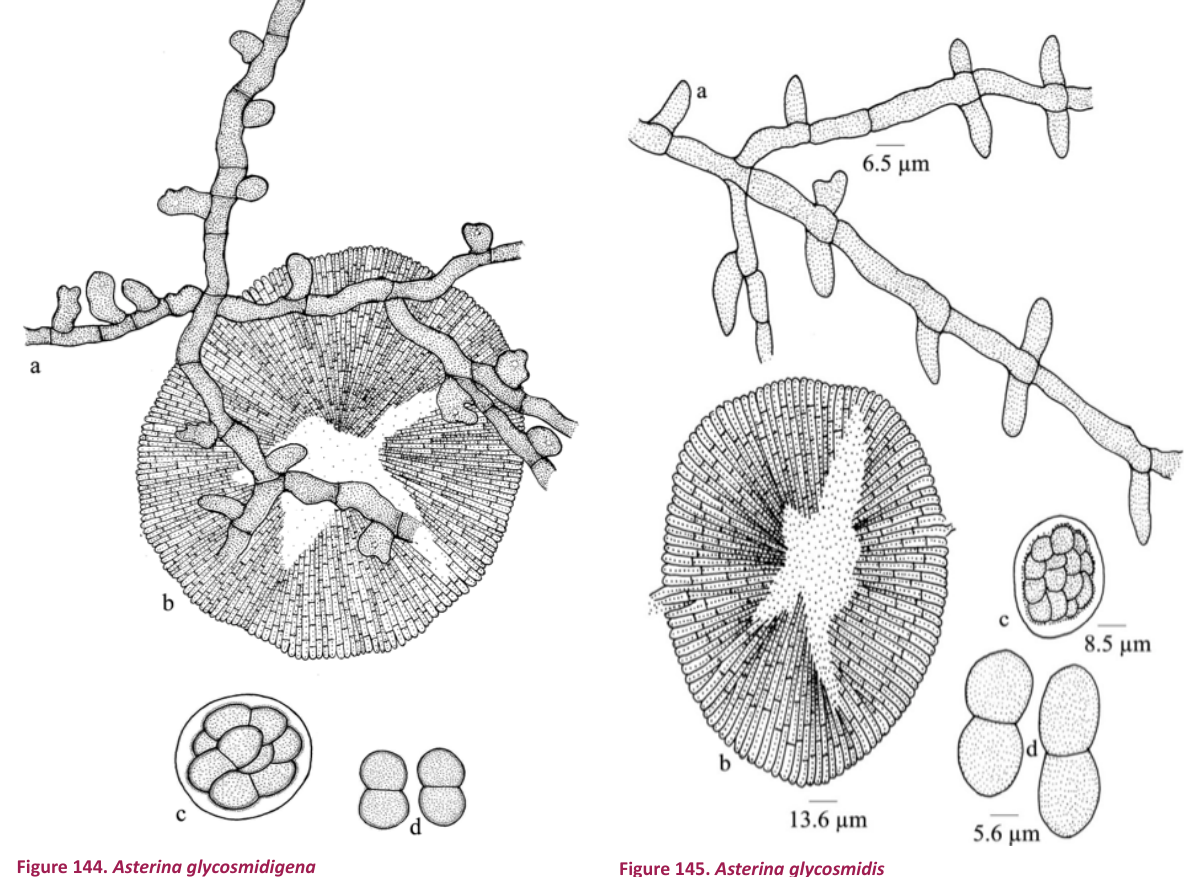
Figure 145. Asterina glycosmidis a - Appressorium; b - Thyriothecium; c - Ascus; d -